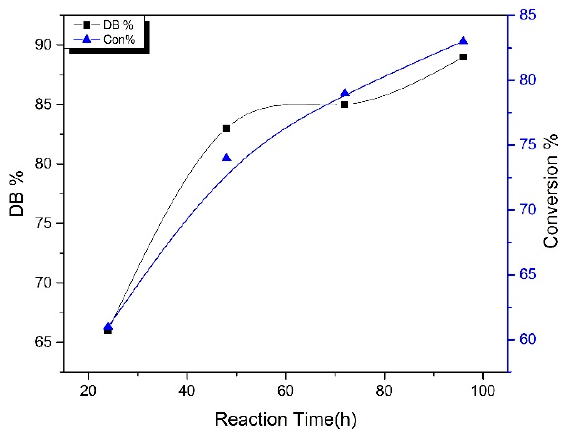
Figure 6. The reaction time vs. DB% and the reaction time vs . Conversion%.